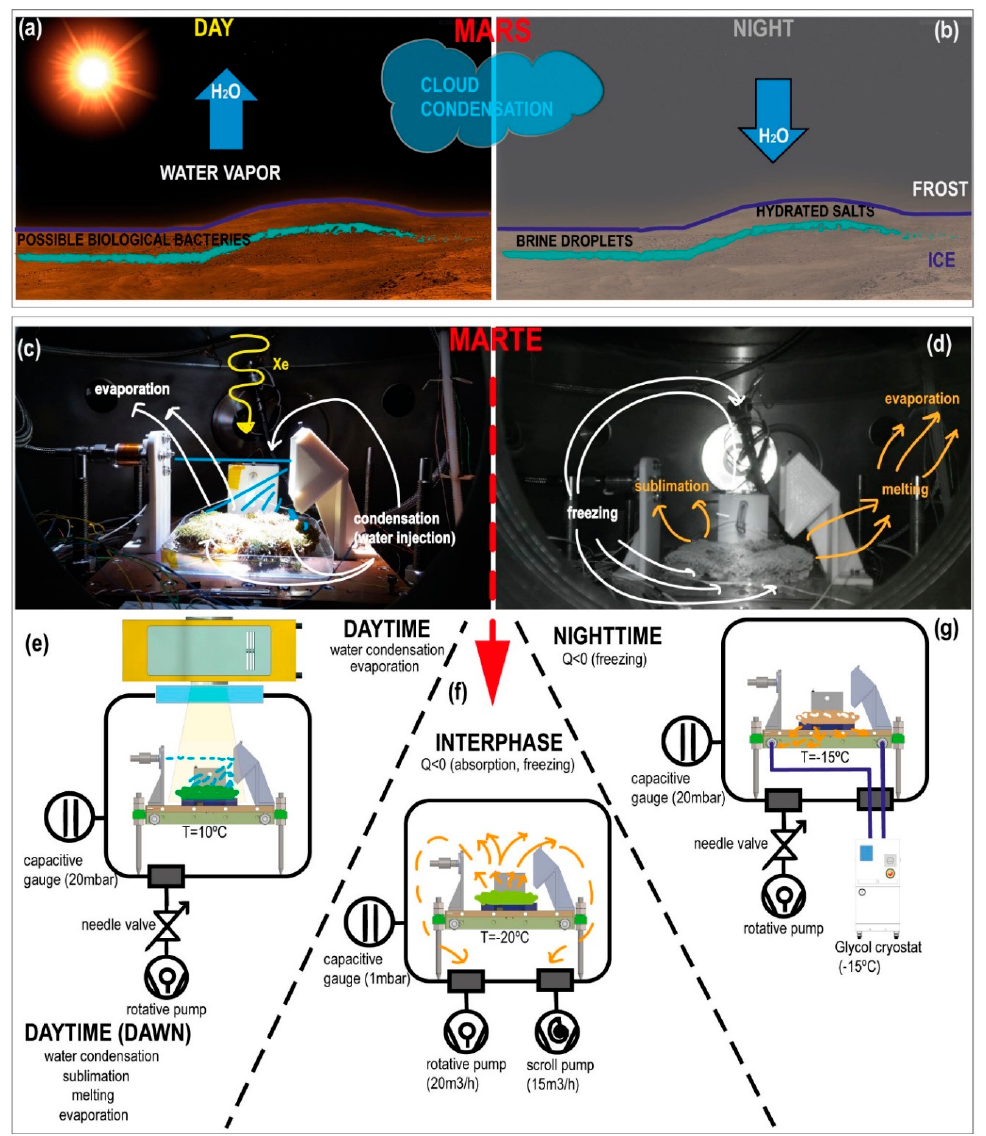
Figure 9. Pictures and technical illustrations of the hydrological cycle in the MARTE vacuum system and on the red planet. ( a ) Daytime in Mars. ( b ) Nighttime in Mars. ( c ) Daytime in MARTE. ( d ) Nighttime in MARTE. ( e ) Technical illustration of daytime in MARTE. ( f ) Technical configuration in MARTE in the interphase between daytime and nighttime. ( g ) Technical illustration of nighttime in MARTE. Table 3. MARTE’s range of environmental variables during hydrological cycle experiments. MARTE Daytime Interphase